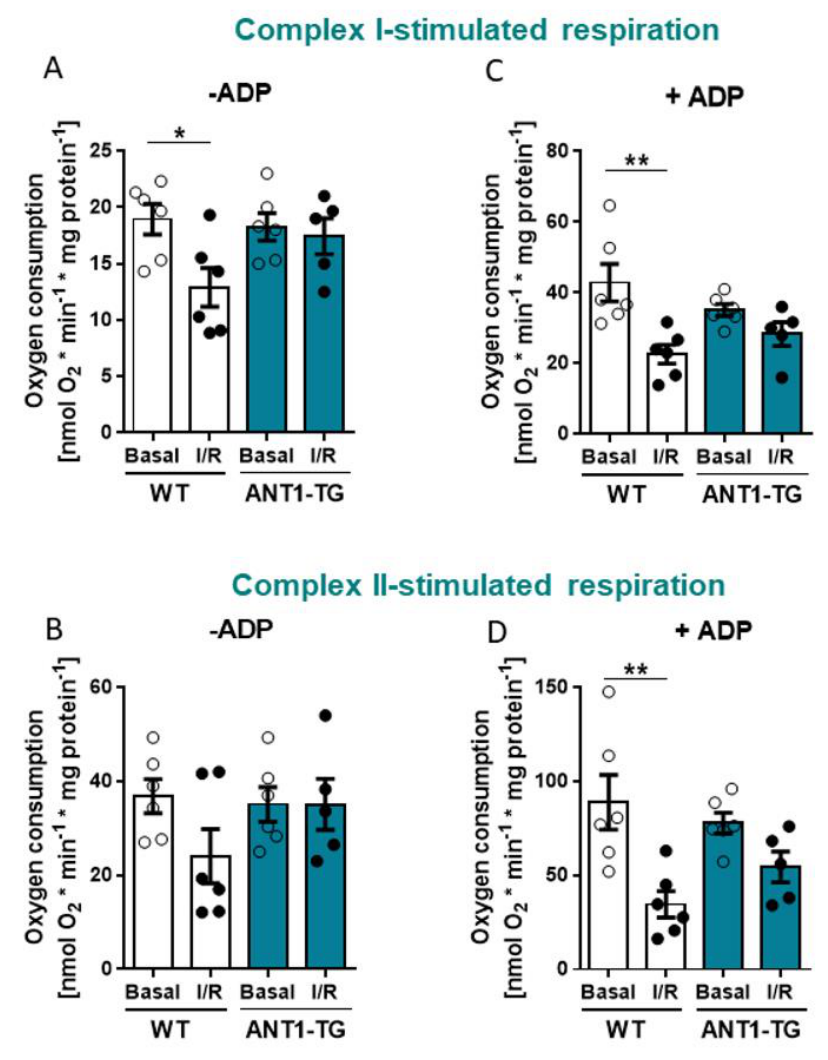
Figure 3. Mitochondrial respiration of cardiac mitochondria. WT and ANT1-TG mitochondria were isolated after 15 min of basal perfusion (Basal) or after 45 min of ischemia, followed by two hours of reperfusion (I/R), and the oxygen consumption was measured with and without the addition of 40 µmol/L ADP. Oxygen consumption in the presence of complex I substrates without ADP ( A ) or with ADP ( C ) and complex II substrates without ADP ( B ) or with ADP ( D ). Data represent the mean ± SEM, * p < 0.05, ** p < 0.01 using the one-way ANOVA or Kruskal – Wallis test with the respective post hoc tests.